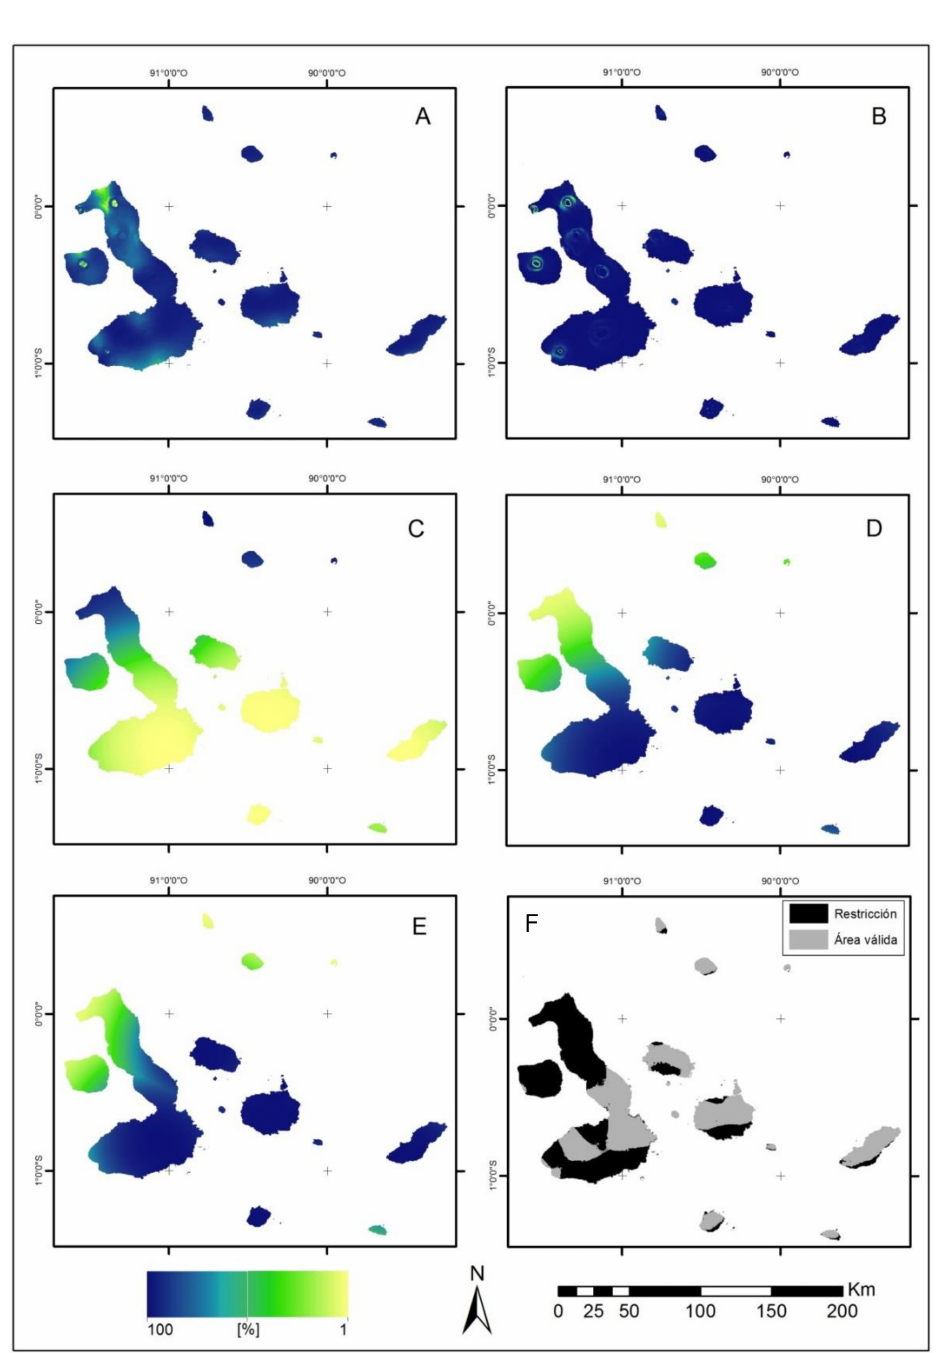
Figure 2. Layer preparation for MCDM on wind farms. ( A ) wind speed ( B ) Terrain slope ( C ) Distance to urban areas. ( D ) substations distance. ( E ) Distance to the road network. ( F ) restricted/empty